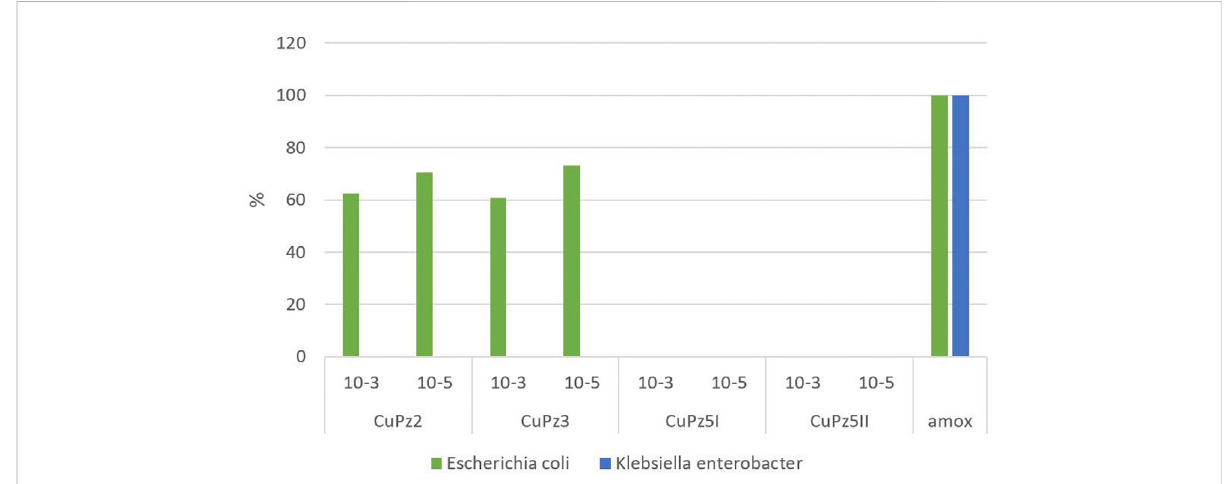
FIGURE 2 Percentage of inhibition achieved by testing Cu(II) complexes in the experiment compared to